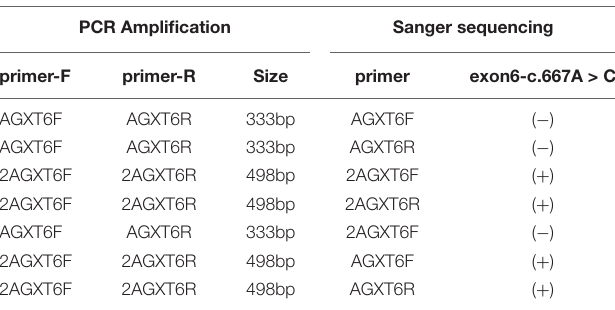
TABLE 3 | Results of mutation screening for AGXT exon-6-mutation (c.667A > C/p.Ser223Arg) by different primers (Primers sequence and positions are provided in see Supplementary Figure S2 ).